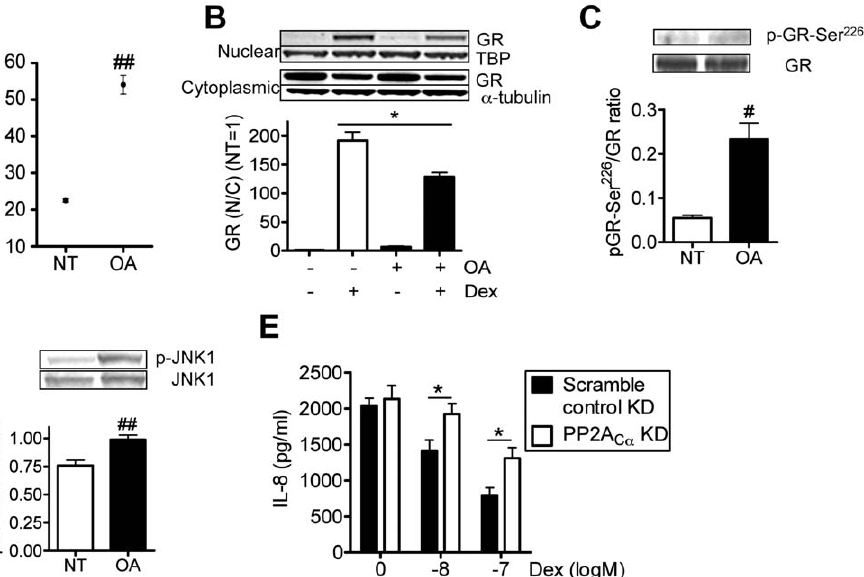
Figure 1. Effects of PP2A inhibitor on glucocorticoid function. Effect of okadaic acid (OA; 10 2 9 M) on corticosteroid sensitivity (A), GR nuclear translocation (B), phosphorylation levels of GR-Ser 226 (C) and JNK1 (D) in U937 cells (n=3–4). E: Effect of PP2A siRNA on IC 50 of dexamethasone on TNF a -induced IL-8 (n=7). Values represent means 6 SEM. # P , 0.05, ## P , 0.01 (vs. non-treatment control; NT), * P , 0.05.